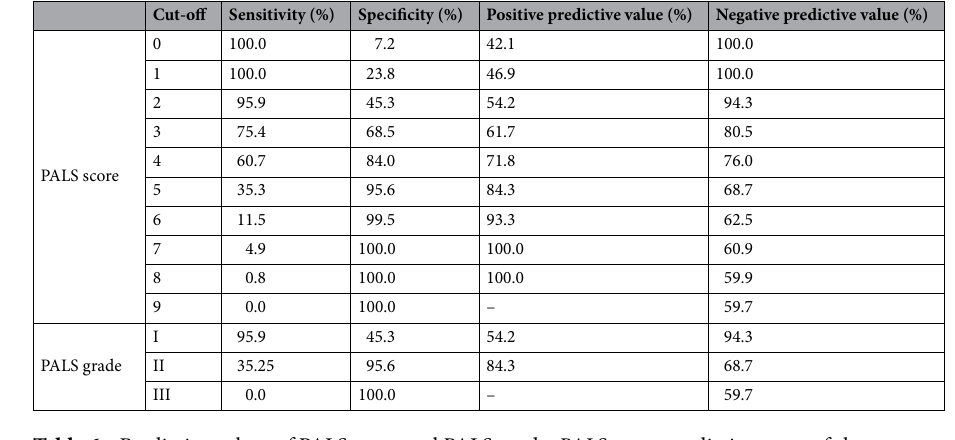
Table 6. Predictive values of PALS score and PALS grade. PALS score , predictive score of short-term prognosis for patients treated with artificial liver support system therapy, PALS grade grade of PLAS score.